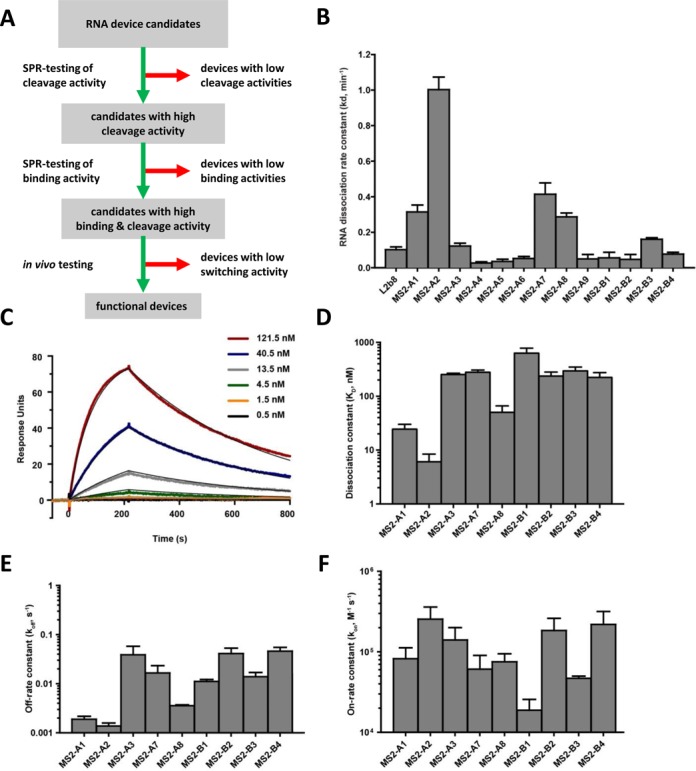
In vitro screening of protein-responsive RNA device cleavage and binding activities. (A) Process flowchart for development of protein-responsive RNA devices. Candidate RNA devices are first screened in vitro by rapid SPR-based assays for RNA cleavage activity, and then for ligand binding activity before in vivo testing. (B) SPR-based RNA dissociation rate constants for MS2-A and MS2-B RNA devices. Reactions were performed at 25°C, in 500 μM MgCl2, 150 mM NaCl and 10 mM HEPES (pH 7.4). Reported values are the mean ± SD of at least three independent assays. RNA device dissociation constants determined in absence of MgCl2 were all <0.01 min−1. (C–F) MS2 protein binding characterization of MS2-A and MS2-B RNA devices. (C) Representative SPR sensorgrams for the MS2-B1 RNA device. Overlaid in the plot is the association and dissociation portion of the sensorgrams from MS2 protein at six different concentrations (121.5, 40.5, 13.5, 4.5, 1.5, 0.5 nM). Representative sensorgrams for other RNA devices are presented in Supplementary Figure S3. Dissociation constants (KD; (D)) for each RNA device are fit by a 1:1 kinetic binding model, taking the ratio of the off-rate constant (koff; (E)) and on-rate constant (kon; (F)). Reported are the mean ± SD from at least three independent assays.